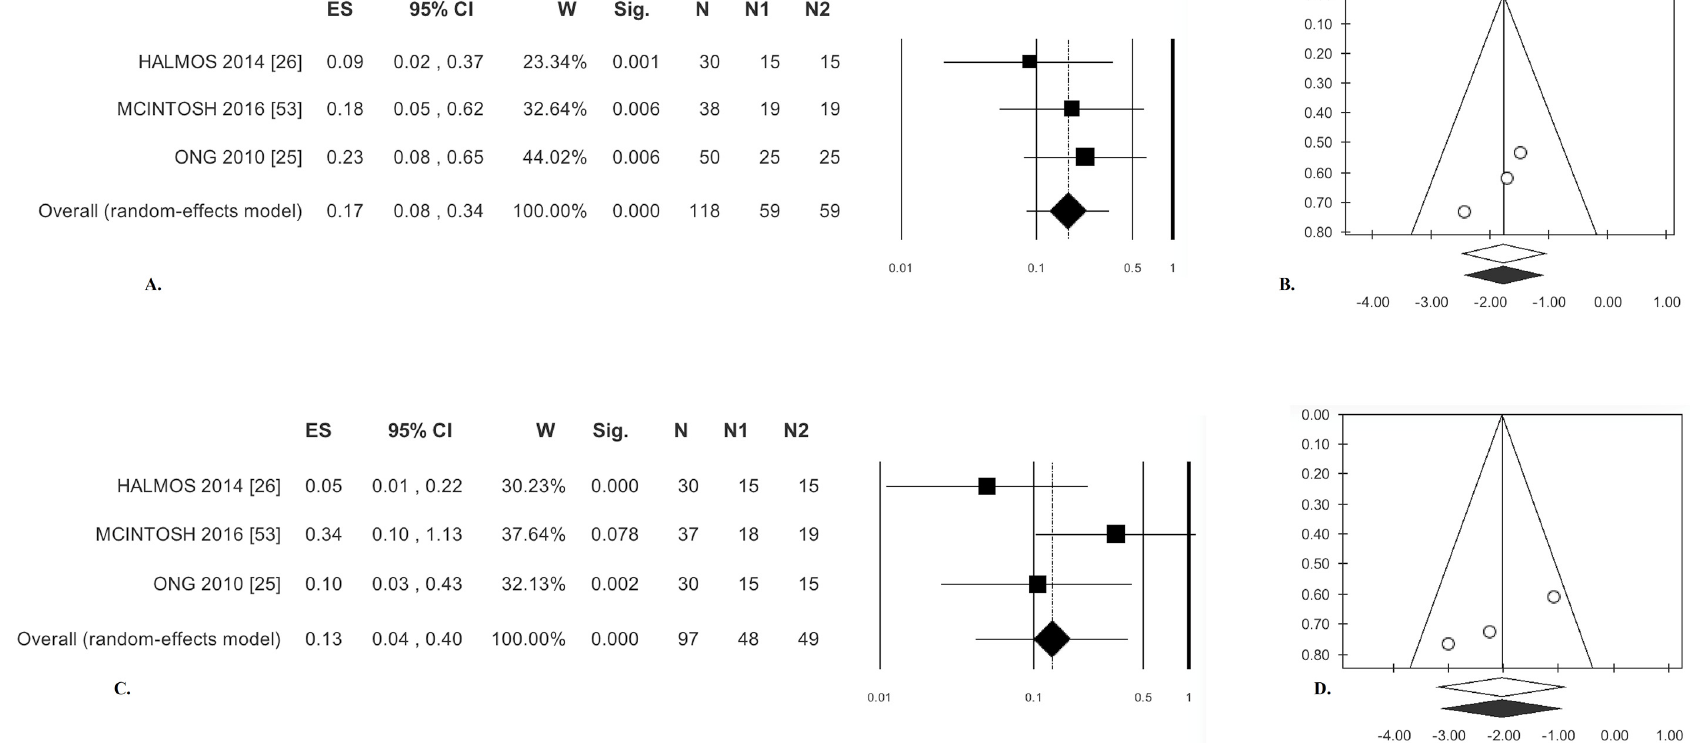
Figure 4. Low ‐ FODMAP diet versus medium/high ‐ FODMAP. Abdominal pain: ( A ) forest plot and ( B ) funnel plot. Bloating: ( C ) forest plot and ( D ) funnel plot.